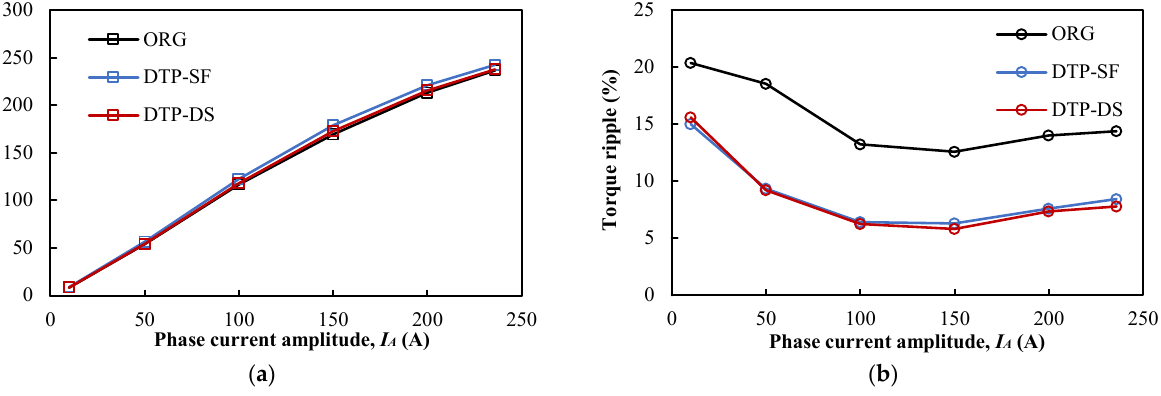
Figure 26. Variations of d- and q-axis inductances with different winding configurations and differ- ent d- and q-axis current combinations: ( a ) ORG: d-axis inductance; ( b ) ORG: q-axis inductance; ( c ) DTP-SF: d-axis inductance; ( d ) DTP-SF: q-axis inductance; ( e ) DTP-DS: d-axis inductance; ( f ) DTP- DS: q-axis inductance.